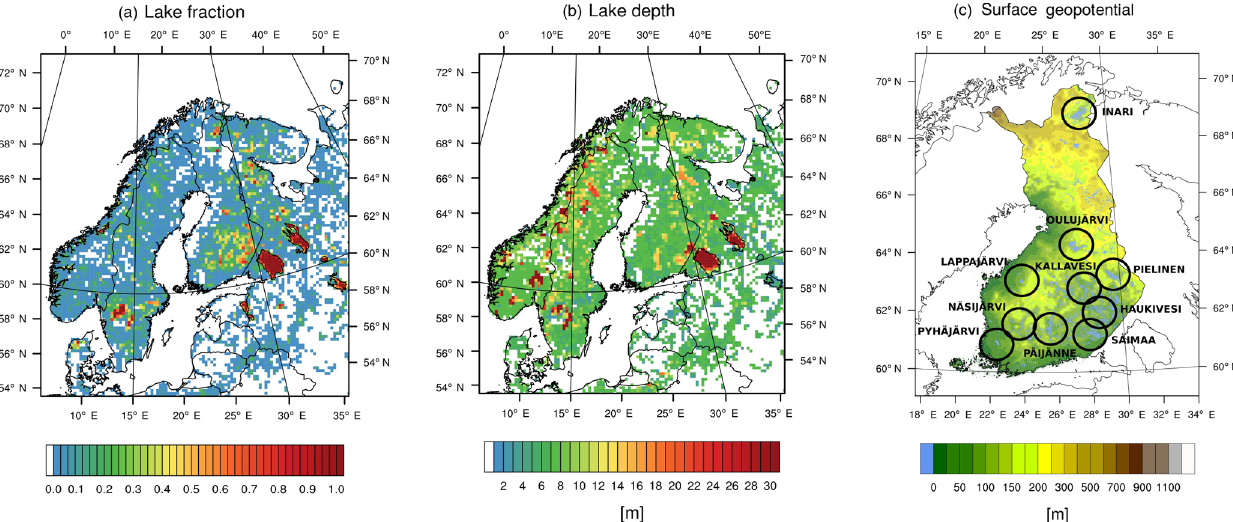
Figure 1. Lake fraction ( a , based on GLCC data) and lake depth ( b , based on Choulga et al., 2014) of the calculation domain. Additionally, the surface geopotential height of Finland and the locations and names of the analyzed Finnish lakes are shown ( c , based on Aalto et al.,